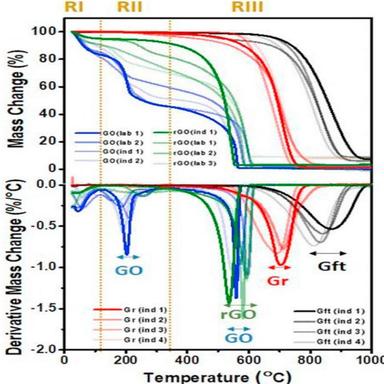
TGA and DTG graphs of several commercially supplied samples (ind) and inhouse prepared (lab) materials of graphite, FLG, rGO and GO confirming their distinctive DTG peaks and Tmax values that can be used for their reliable qualitative identification. (A colour version of this figure can be viewed online.)